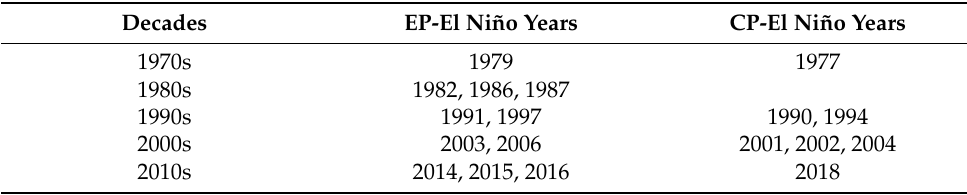
Table 3. The EP-El Niño and CP-El Niño years using the detrended SST for each decade from 1854. (Only the data from 1977 to 2018 were listed. The El Niño years in 2010s derived from the China Meteorological